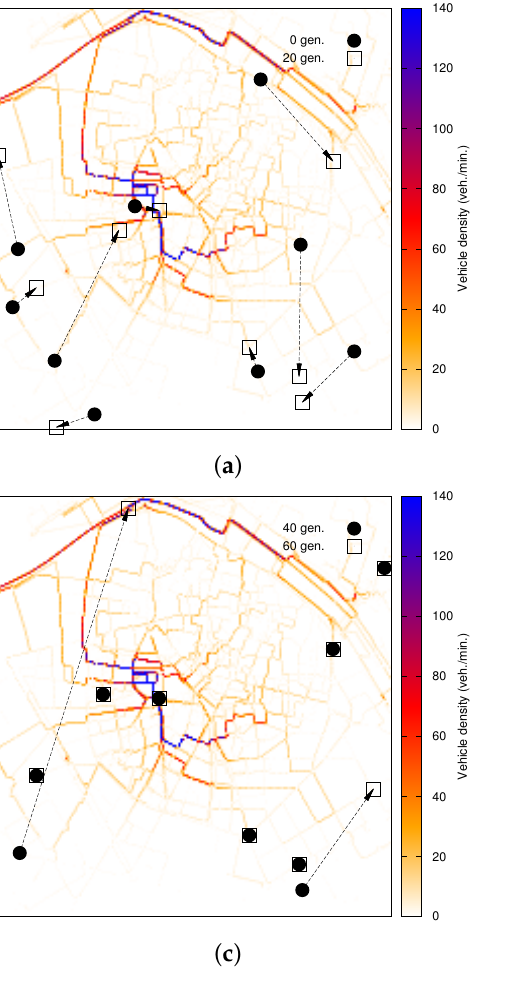
Figure 8. Evolution of the deployment of nine RSUs in the Valencia scenario using GARSUD. ( a ) After 20 generations; ( b ) after 40 generations; ( c ) after 60 generations; ( d ) after 80